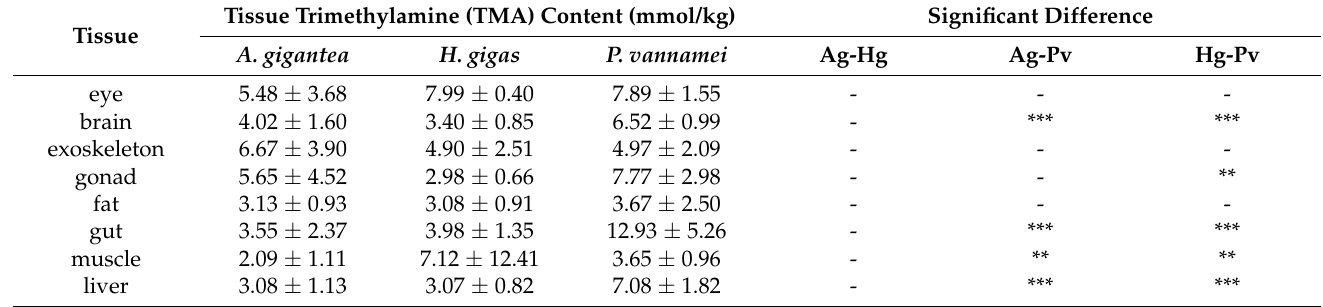
Table 2. The trimethylamine (TMA) content (unit: mmol/kg wet weight; mean ± SD) across eight tissues in three